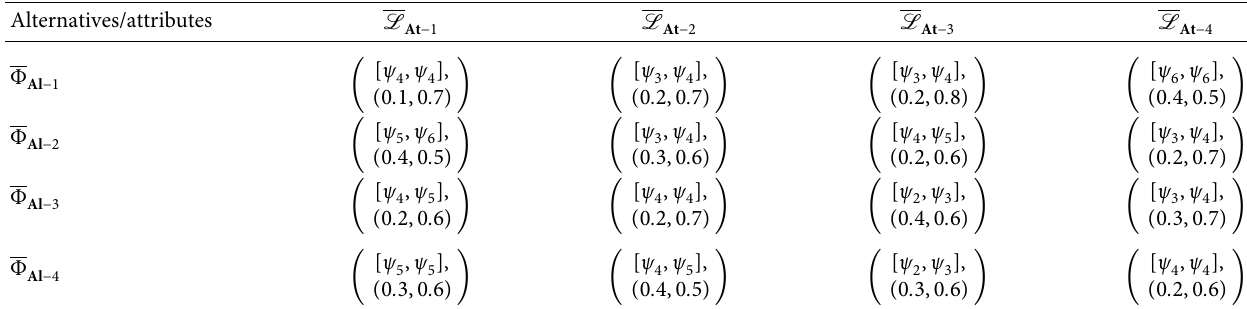
Table 12: Decision matrix provided by expert � R 2 in terms of CIULNs.